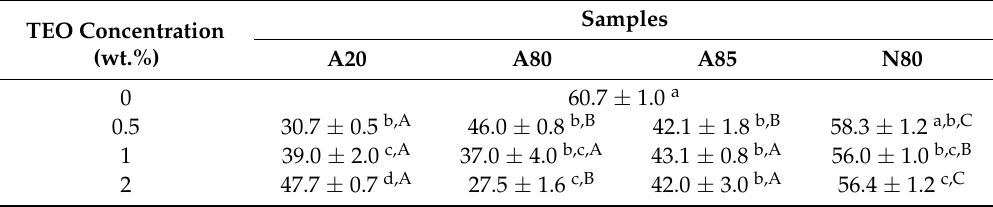
Table 6. Contact angles ( ◦ ) of chitosan